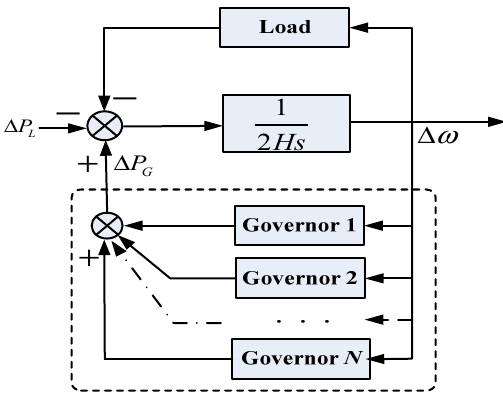
Figure 1. Typical model of a power system to analyze the frequency behavior.